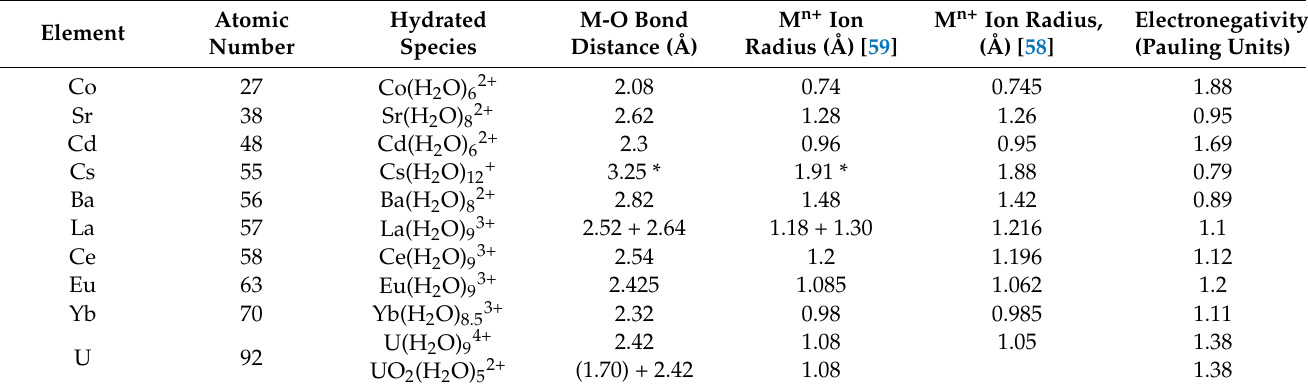
Table 8. Chemical properties of some selected metal ions (under